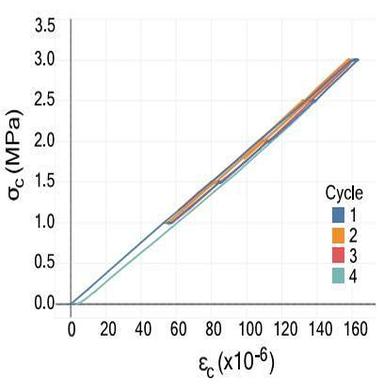
(a) Square of S-wave speed 21 with respect to axial compressive strain. (b) Square of the fundamental torsional frequency of vibration, ( ,1 ) 2 , with respect to compressive strain, where dashed lines indicate loading-increasing stage of cycle 1 and unloading of cycle 4.